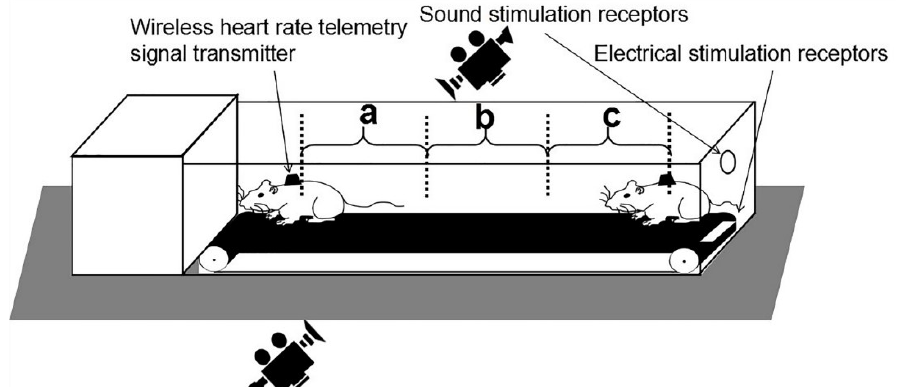
Figure 1 - Ethological observation and synchronous telemetry of heart rate during treadmill